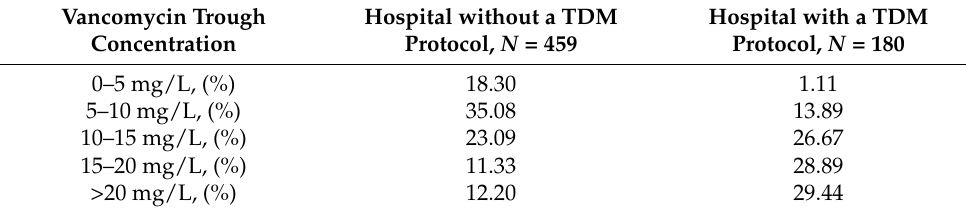
Table 7. Comparative analysis of vancomycin levels during vancomycin therapy. Vancomycin Trough Hospital without a TDM Concentration Protocol, N = 459